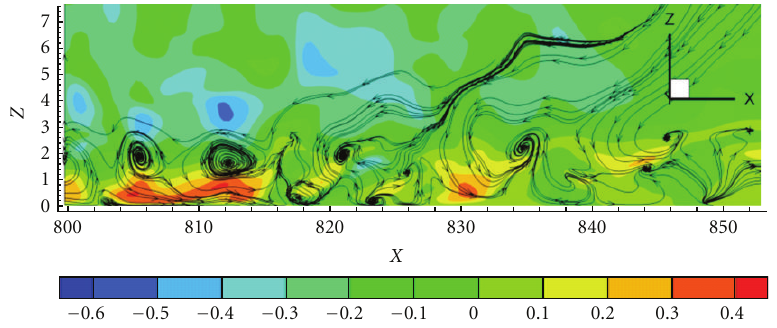
Figure 26: Visualization of isosurface λ 2 and velocity perturbation at y = 4 for ( X , Z )-Plane t = 15 T .